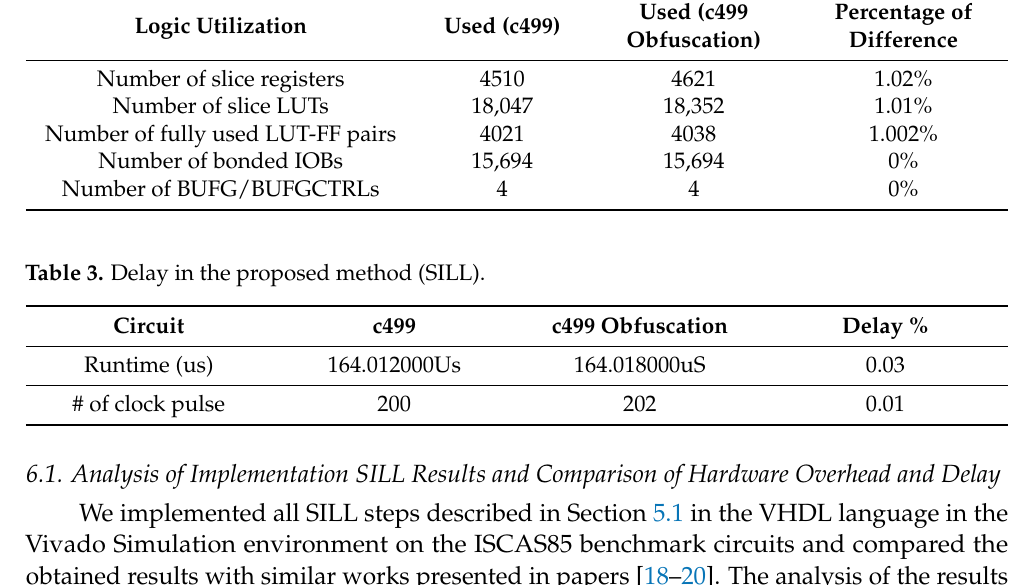
Figure 13. Comparison of overhead consumption of the proposed method (SILL) with three similar methods. Figure 14. Comparison of the proposed method delay (SILL) with two similar methods.